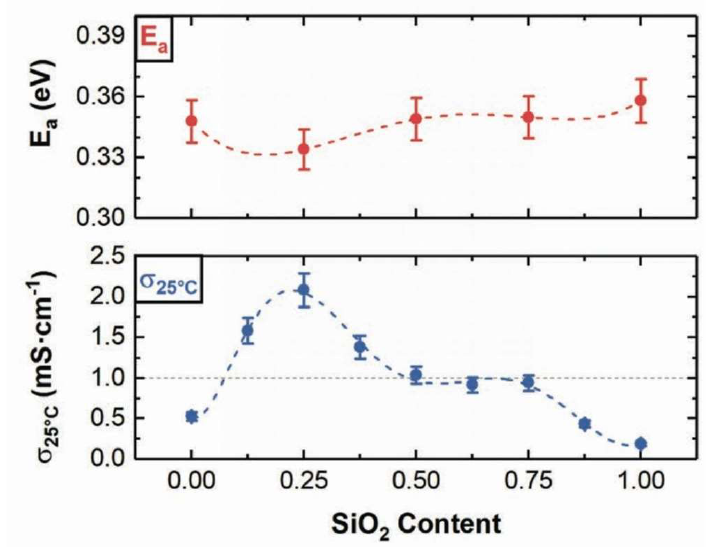
Figure 2. (Top) Activation energy and (bottom) room temperature ionic conductivity of aLi 2 S- γ B 2 S 3 -xSiO 2 -zLiI (LIBOSS) with varying silica content [11] .